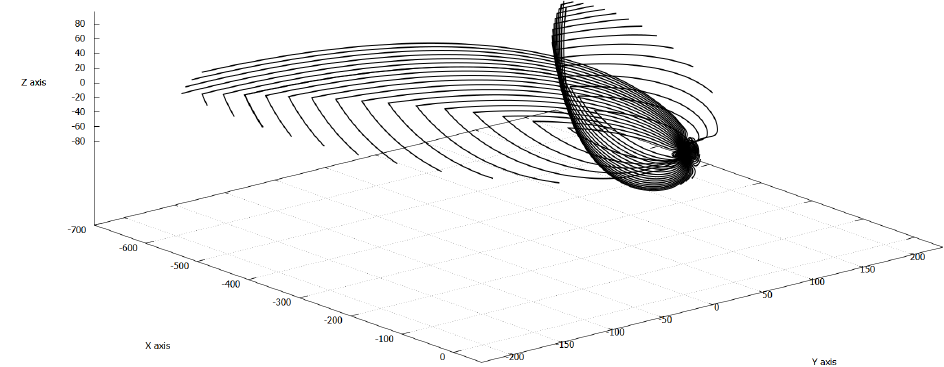
Figure 6. Example of the 3-D structure of Saturn’s magnetosphere for southward IMF in case 1 (see Table 1).